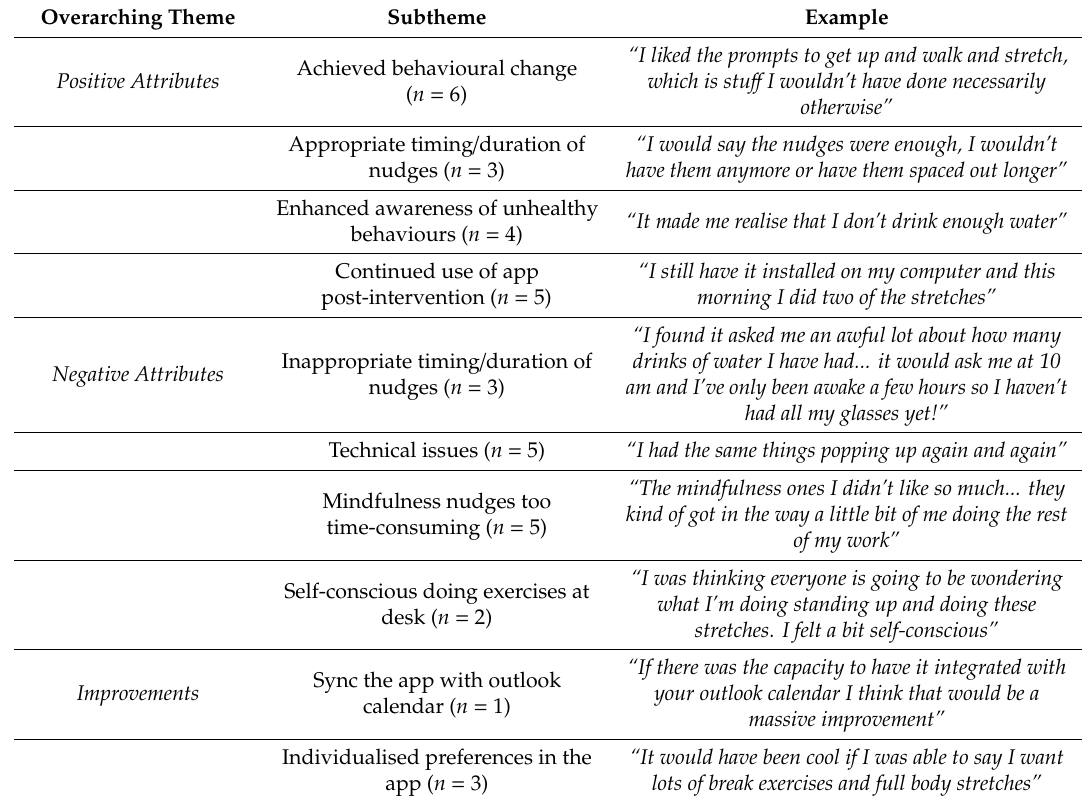
Table 6. Overall themes, first-order themes, and participant quotations ( n =